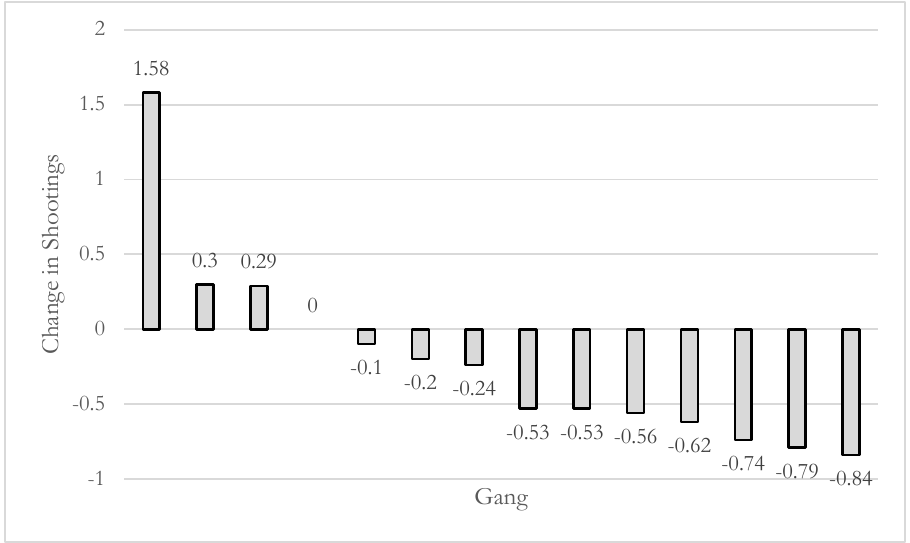
Figure 1. Average change per quarter in counts of gang-related (by known perpetrator) shootings (n = 14). Note: Post period for each gang begins in the first quarter that the gang was “called in”.